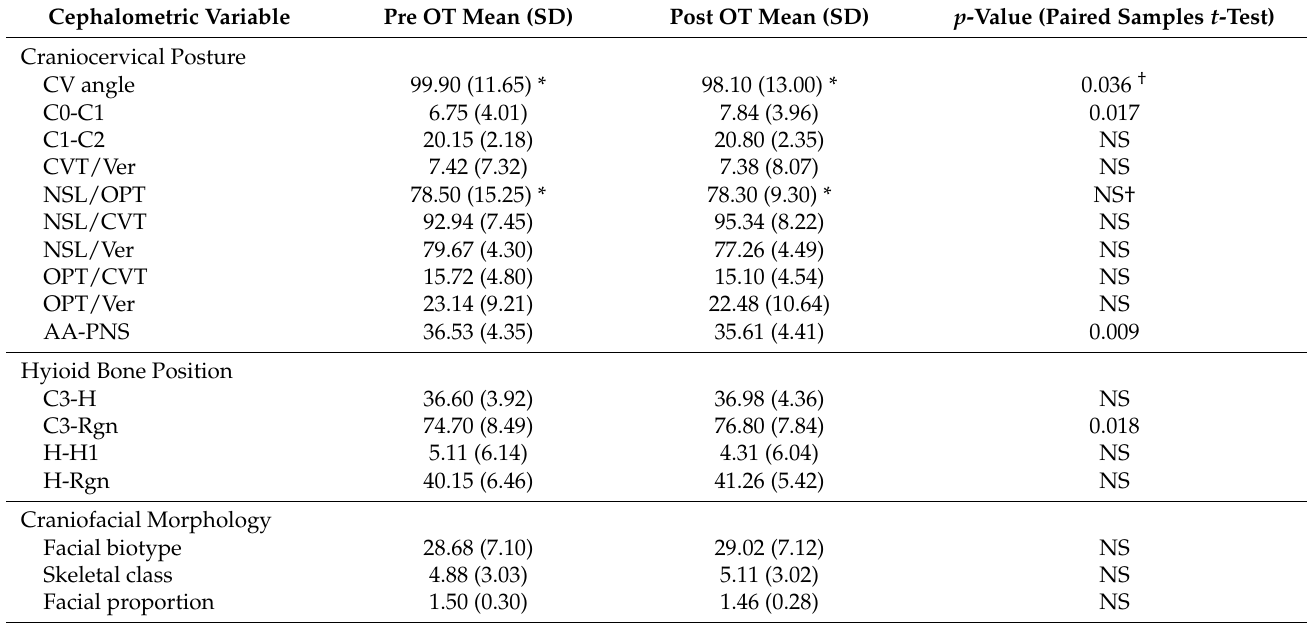
Table 3. Cephalometric variables at two moments: pre-orthodontic treatment and post-orthodontic treatment ( n = 42). Cephalometric